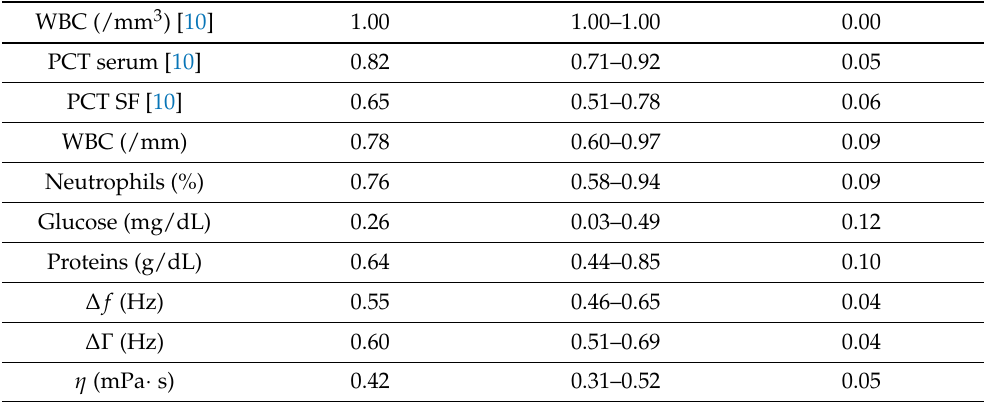
Table 5. Area under the ROC curve values for the parameters as predictors for infectious fluid (SF in tubes with EDTA).